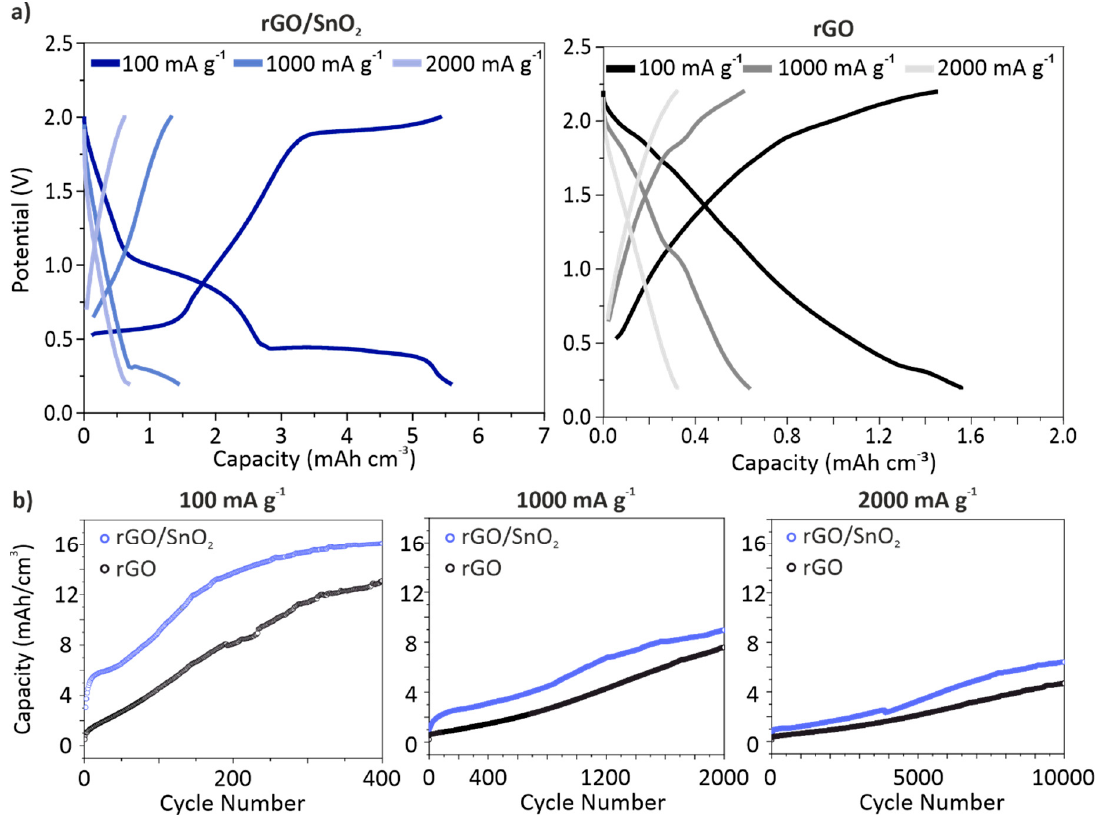
Figure 6. ( a ) Charge–discharge profiles of the hybrid rGO / SnO 2 (left) and pristine rGO (right) electrodes at the 10th cycle. ( b ) Rate performance of electrodes at a current density of 100, 1000 and 2000 mA g − 1 . Their volumetric energy storage capacity was calculated for a compressed electrode with a thickness of 100 µm.